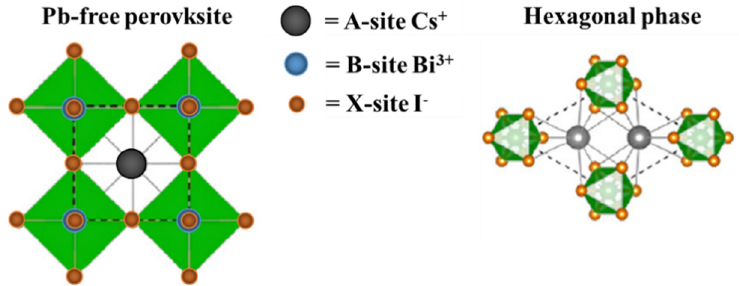
Figure 1. Illustrations depicting the crystal structures of the conventional perovskite and the hexagonal-phase-ordered-vacancy perovskite structure adopted by Cs 3 Bi 2 I 9 .